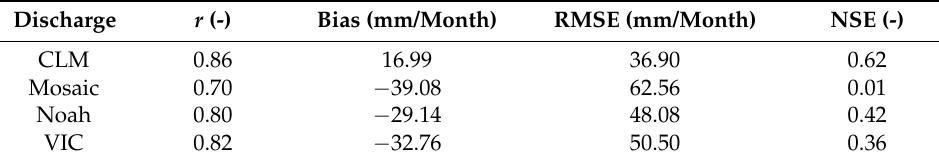
Figure 10. Comparison of the satellite-based discharge and LSM-based discharge; ( a ) Satellite-CLM; ( b ) Satellite-Mosaic; ( c ) Satellite-Noah; ( d ) Satellite-VIC. Table 6. Statistical results of model-based discharge compared to satellite-based discharge in the Korean Peninsula.